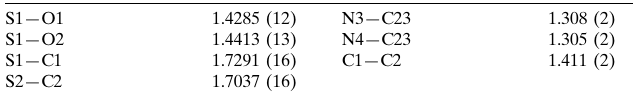
Selected bond lengths (A˚ ).